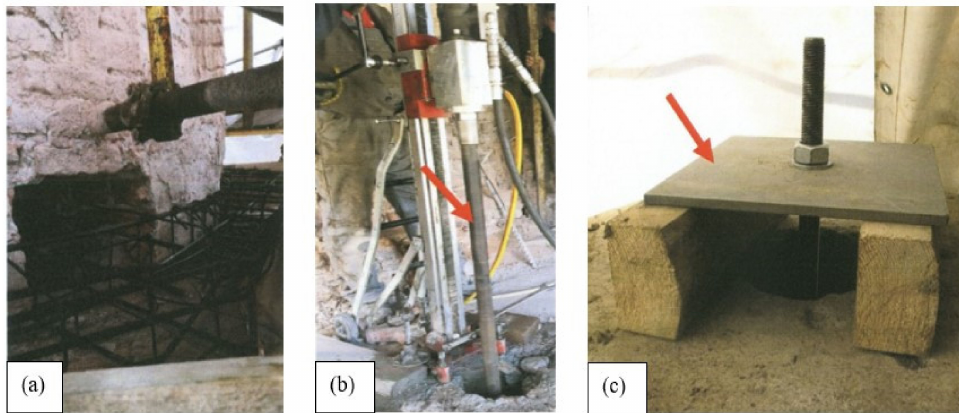
Figure 12. Vertical steel rods. Stages of installation: ( a ) Reinforced concrete girders, ( b ) Drilling of galleries, ( c ) Insertion and fixing of the steel